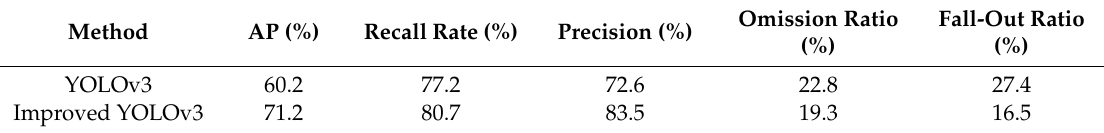
Table 8. Verification results for VEDAI.